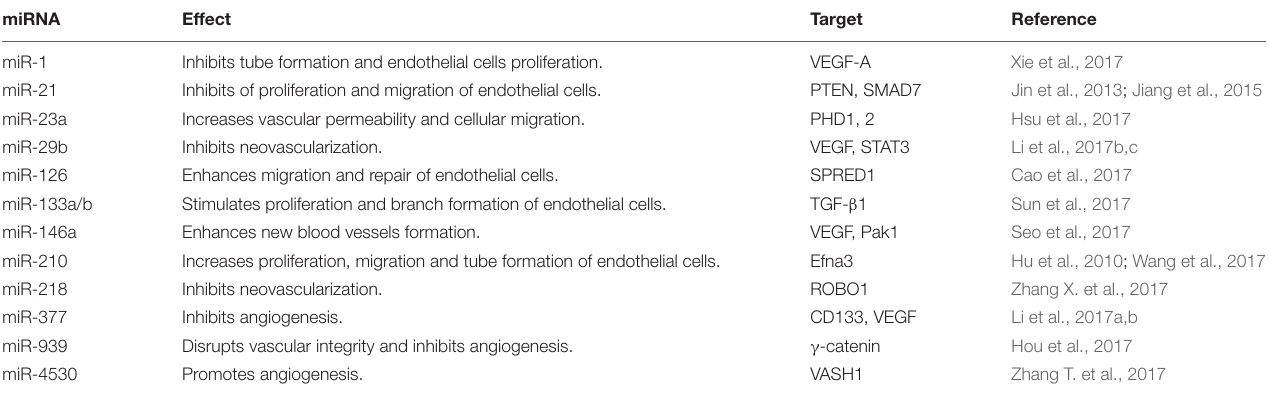
TABLE 2 | miRNAs involved in the angiogenesis process of wound healing. miRNA